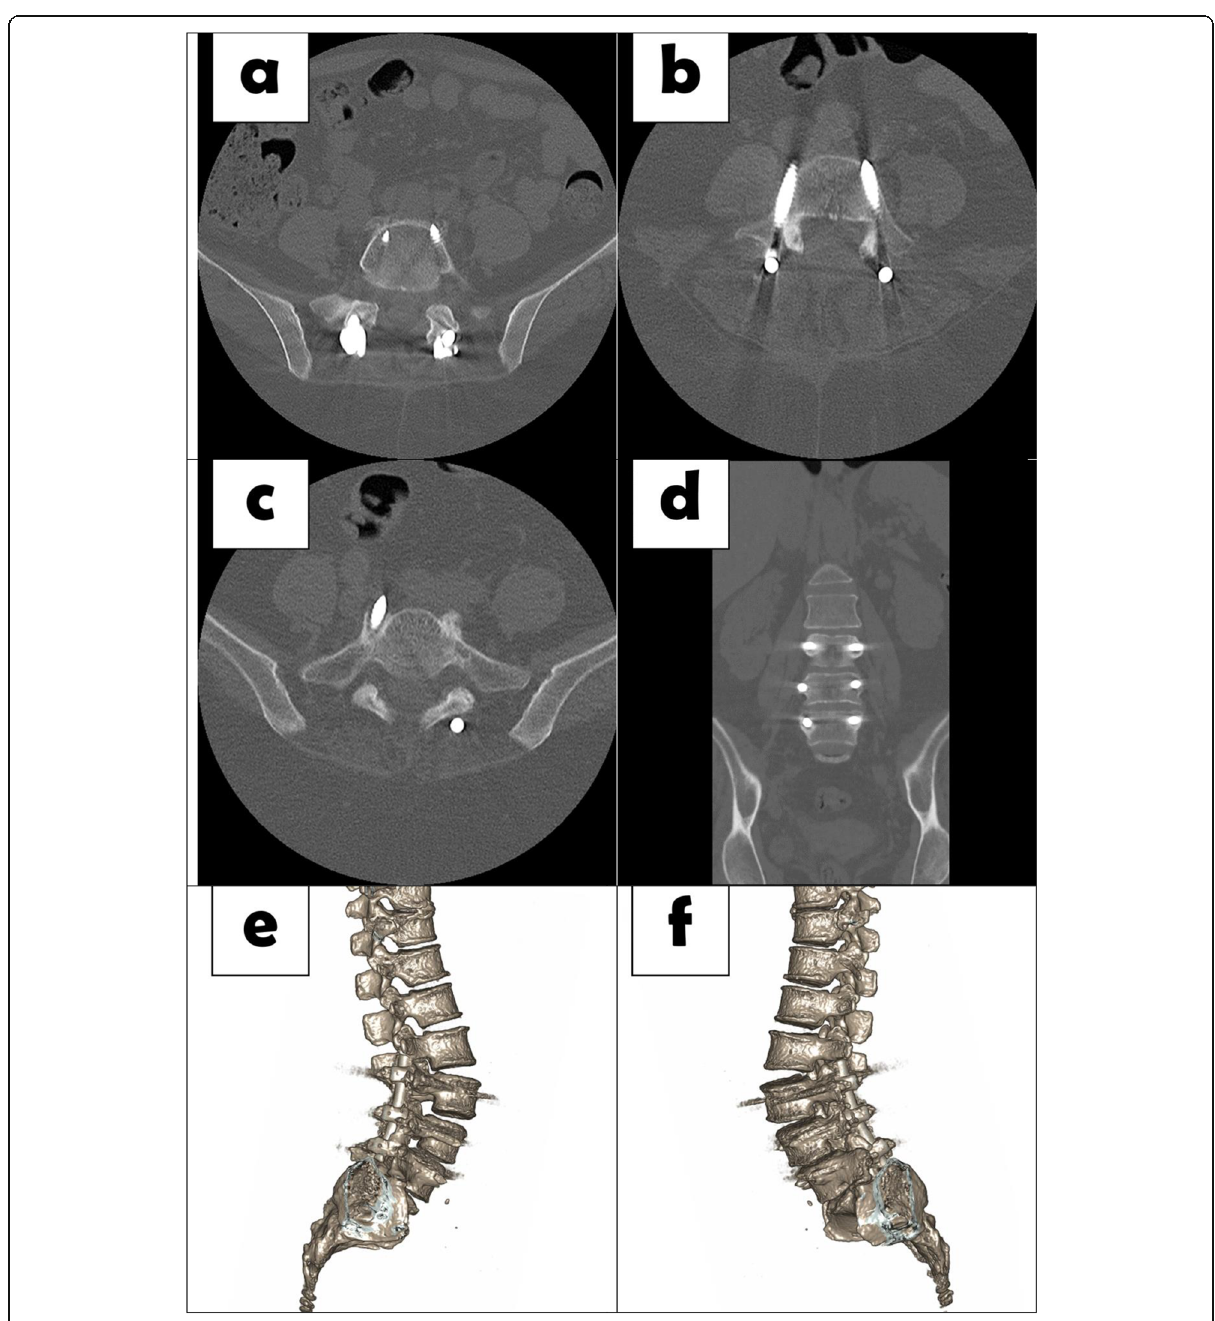
Fig. 1 Internal fixation of L3, L4, and L5 vertebrae with rods and multiple screws. a – c Axial cuts are showing penetration of the anterior and lateral aspects of L4 and L5 vertebrae with two screws and lateral violation of the screw in the right pedicle (grade II). d Coronal reconstruction is showing the lateral location of the screws in L4 and L5 vertebrae. e , f 3D reconstruction sagittal cuts confirm the anterior penetration and lateral location of the screws in L4 and L5 vertebrae and their